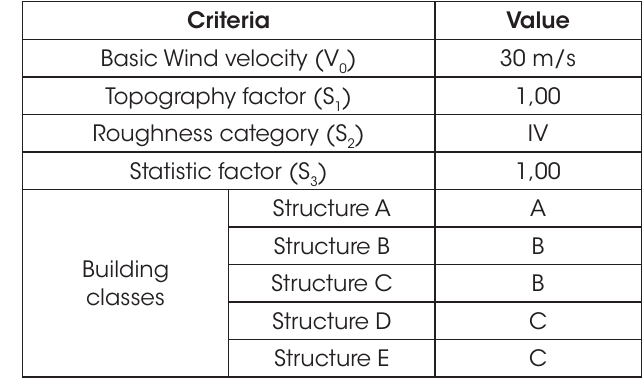
Criteria for the definition of the wind